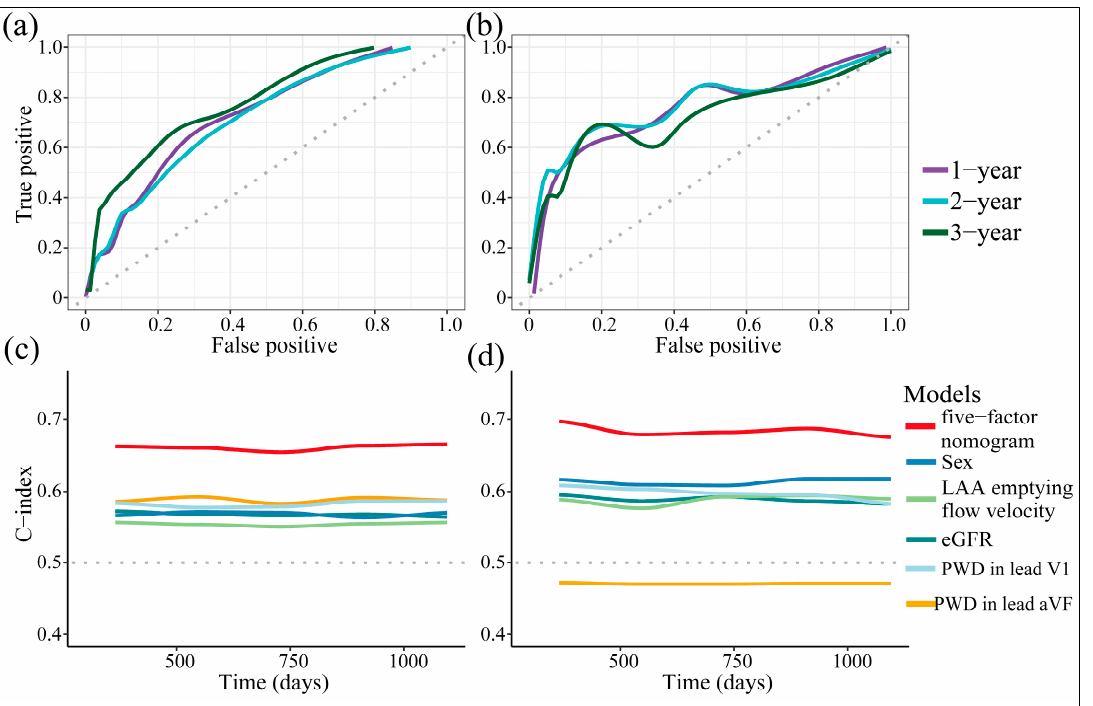
Figure 5. Time-dependent ROC curves across 1, 2, and 3 years after ablation ( a ) and internally validated ( b ), with c-index analyses ( c ) and internally validated ( d ).